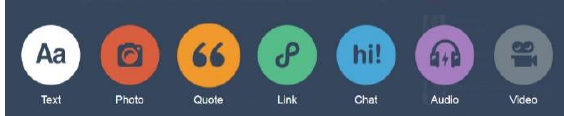
Figure 1. Tumblr dashboard.